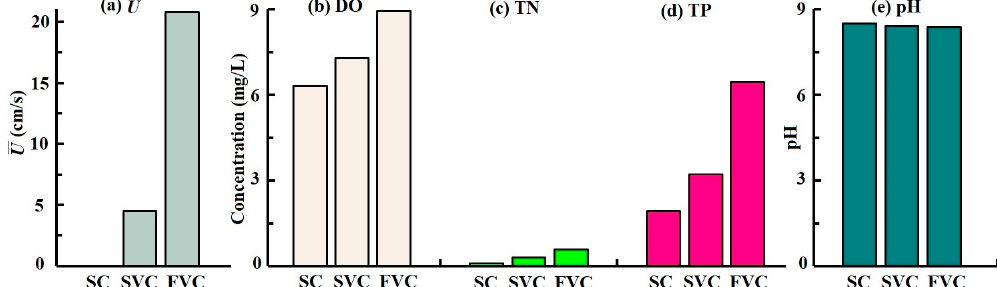
Figure 3. Velocity conditions and physicochemical properties in each water-sediment system. ( a ) Average vertical velocity ( 𝑈(cid:3365) ), ( b ) Dissolved oxygen (DO), ( c ) Total phosphorus (TP), ( d ) Total nitrogen (TN), ( e ) pH. SC: static control, SVC: slow velocity condition, FVC: fast velocity condition. All the data were the average values from 0 weeks to 5 weeks, and were statistically significant with a p -value <